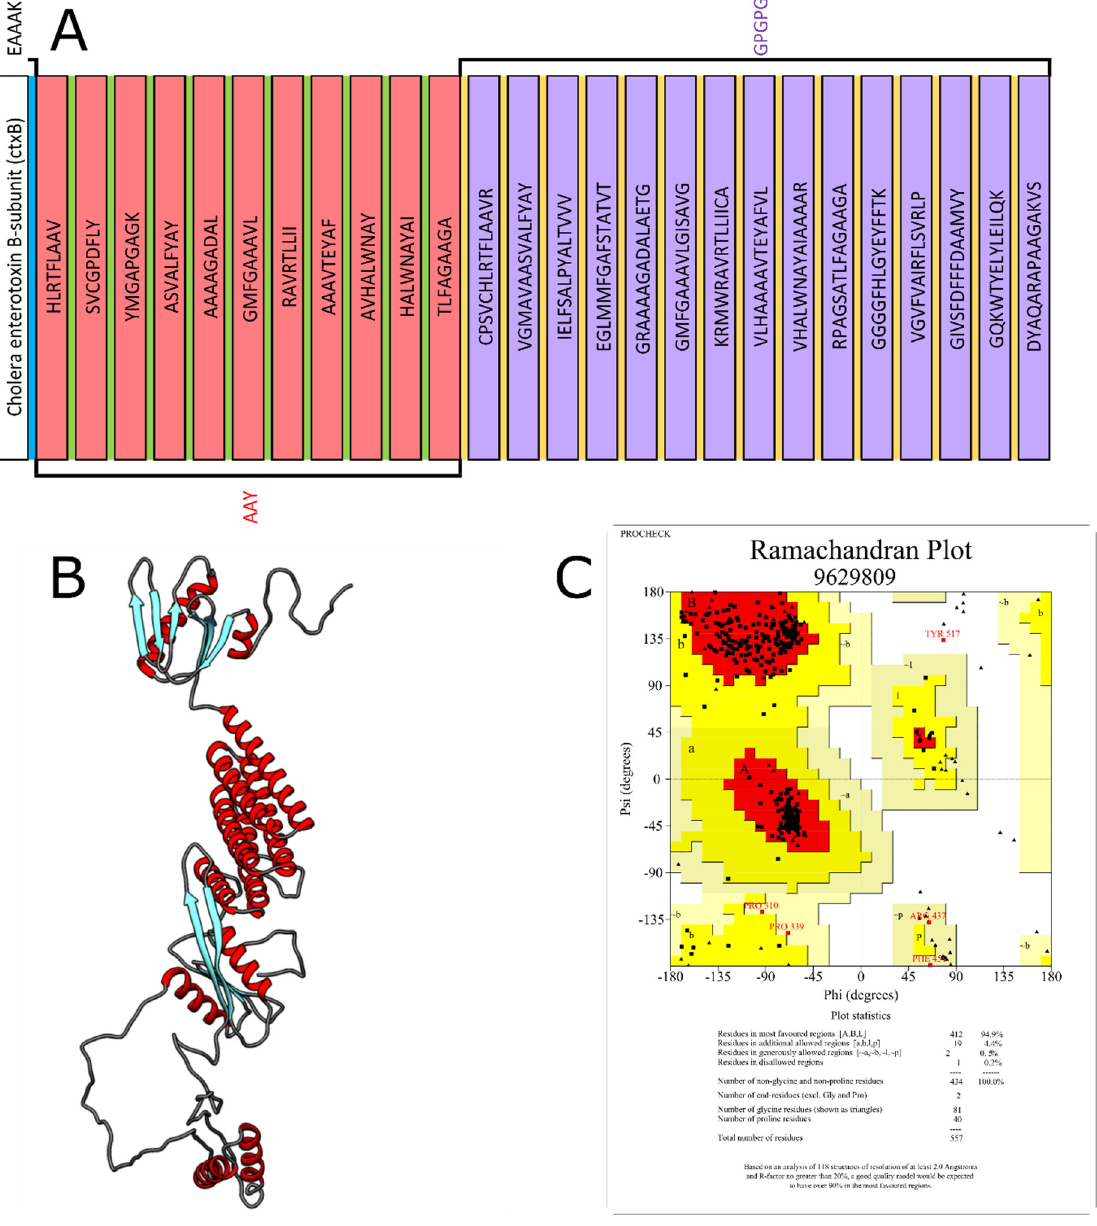
Figure 1. ( A ) Multi-epitope immunogen (Tpme-VAC/LGCM-2022) construct with highlighted peptide linkers and epitopes. Sequence length is 558 amino acid residues. ( B ) Three-dimensional structure modelling of the chimeric protein after refinement by GalaxyRefiner. ( C ) Ramachandran plot for the model after refinement, showing 94.9% residues in most favored regions and 0.2% in disallowed regions.